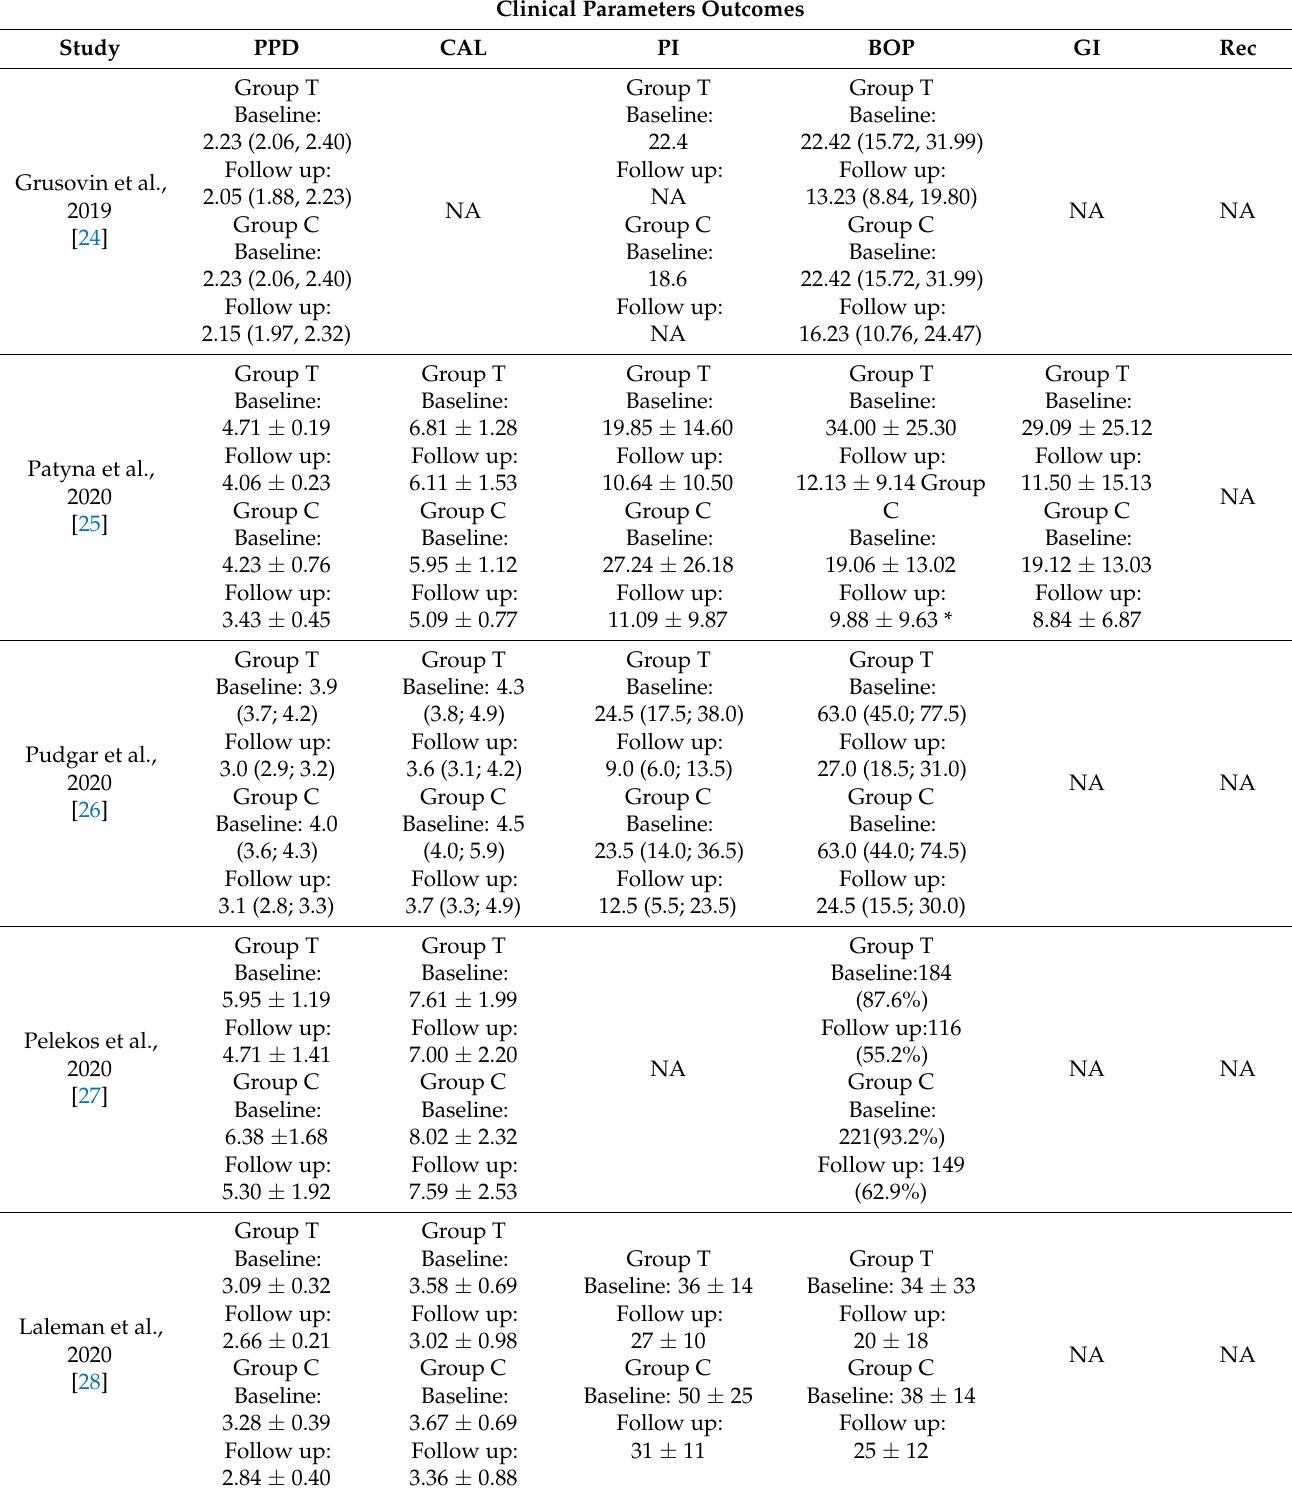
Table 3. Cont. Clinical Parameters